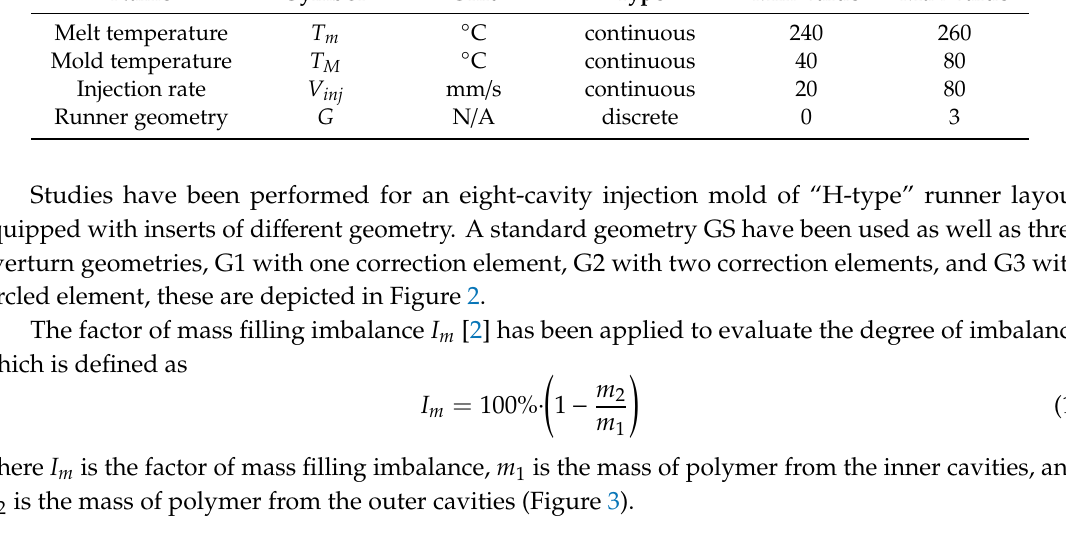
Table 1. Range of optimized process parameters.